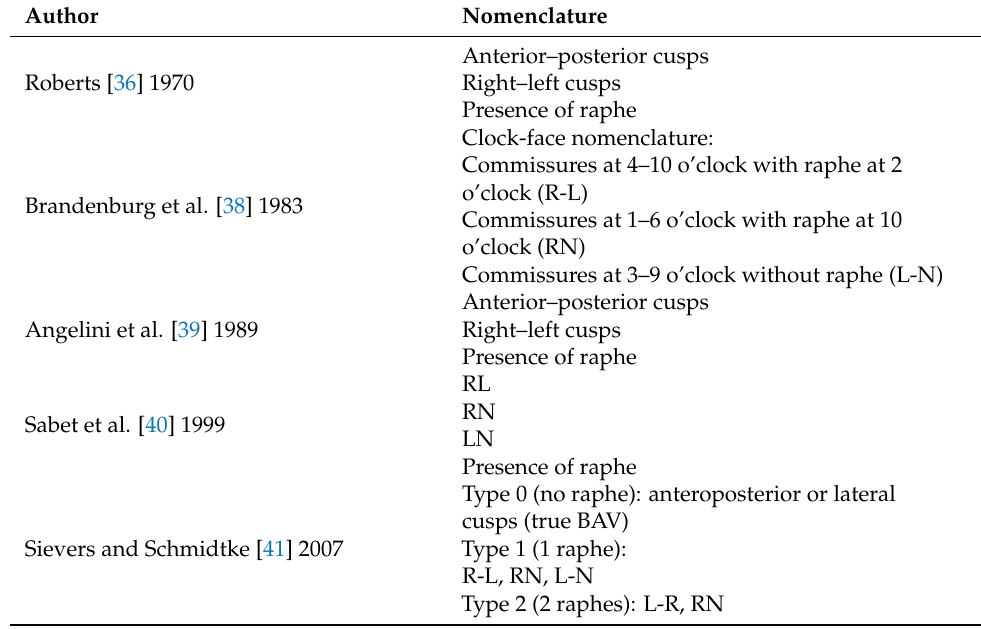
Table 3. BAV classifications (adapted from Michelena HI et al./European Journal of